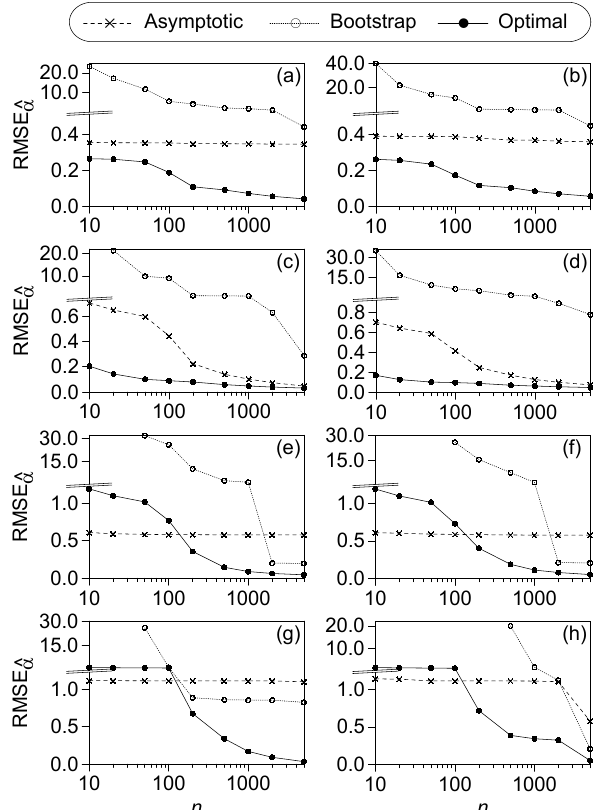
Figure 1. RMSE of the estimated heavy tail parameter in depen- dence on data size for the Hill estimator and various order selec- tors: optimal (Algorithm 1), asymptotic normality and bootstrap. The Monte Carlo design parameters are prescribed persistence time, τ = 0 . 0 (a, c, e, g) and τ = 0 . 8 (b, d, f, h) ; prescribed heavy-tail pa- rameter, α = 0 . 5 (a, b) , α = 1 . 0 (c, d) , α = 1 . 5 (e, f) and α = 2 . 0 (g, h) ; and number of simulations, n sim = 10000. Note the broken y